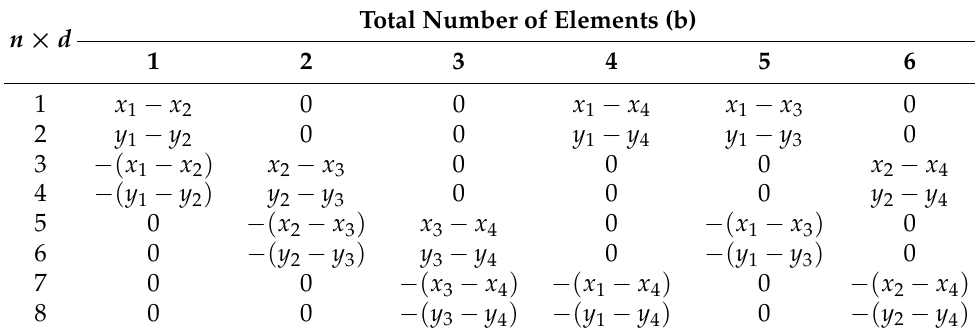
Table 2. The equilibrium matrix of the 2D two-strut tensegrity structure.